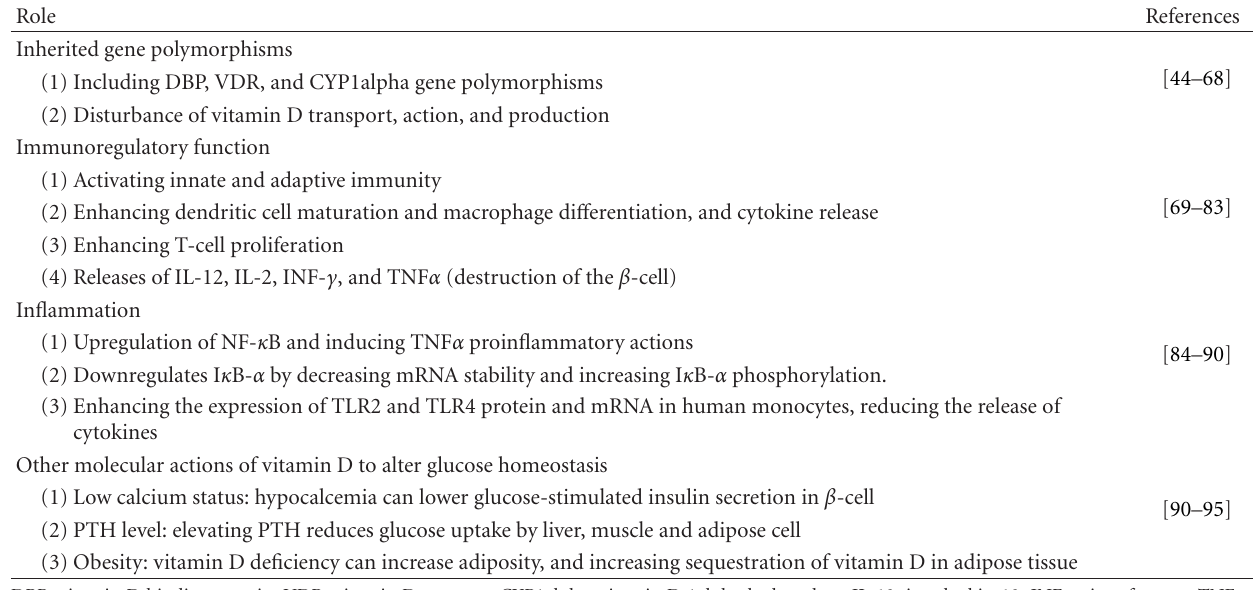
Table 1: Role of vitamin D deficiency in insulin